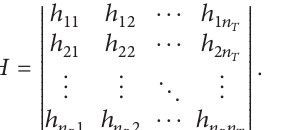
(Figure 9). The result of MIMO channel capacity improve- ment is given in Section 5 and conclusions are given in Section